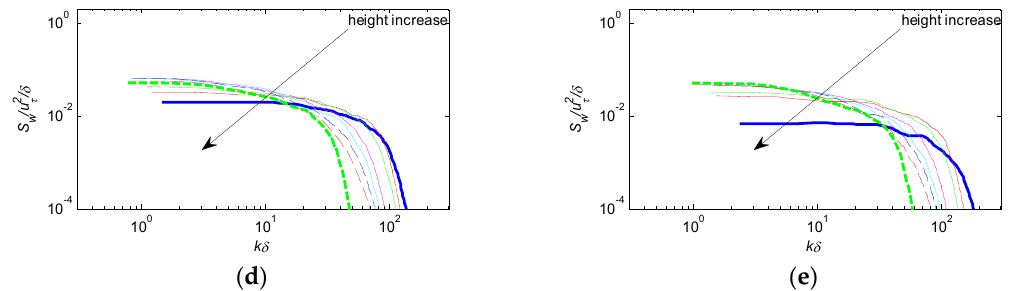
Figure 12. Power spectra of wall-normal velocity fluctuations. ( a ) case 1, ( b ) case 2, ( c ) case 3, ( d ) €e 4 and ( e ) case 5. The height indicators for each graph are the same as those shown in Figure 9a, that is, 7.5 m, 27.5 m, 47.5 m, 67.5 m, 87.5 m, 107.5 m, 127.5 m, and 147.5 m.